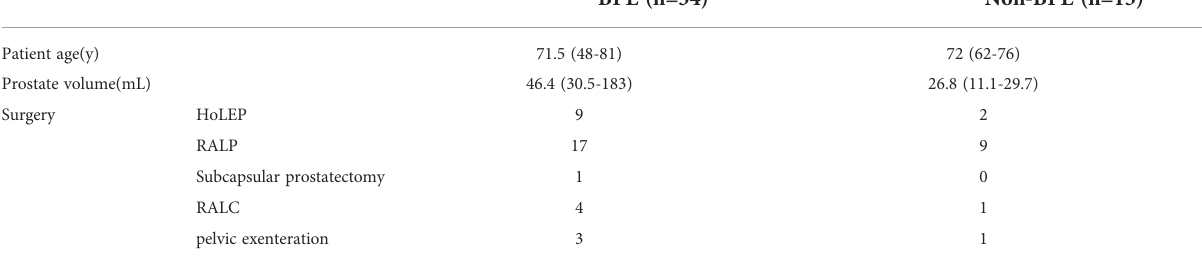
TABLE 2 Background characteristics of patients from whom prostate tissue was taken .